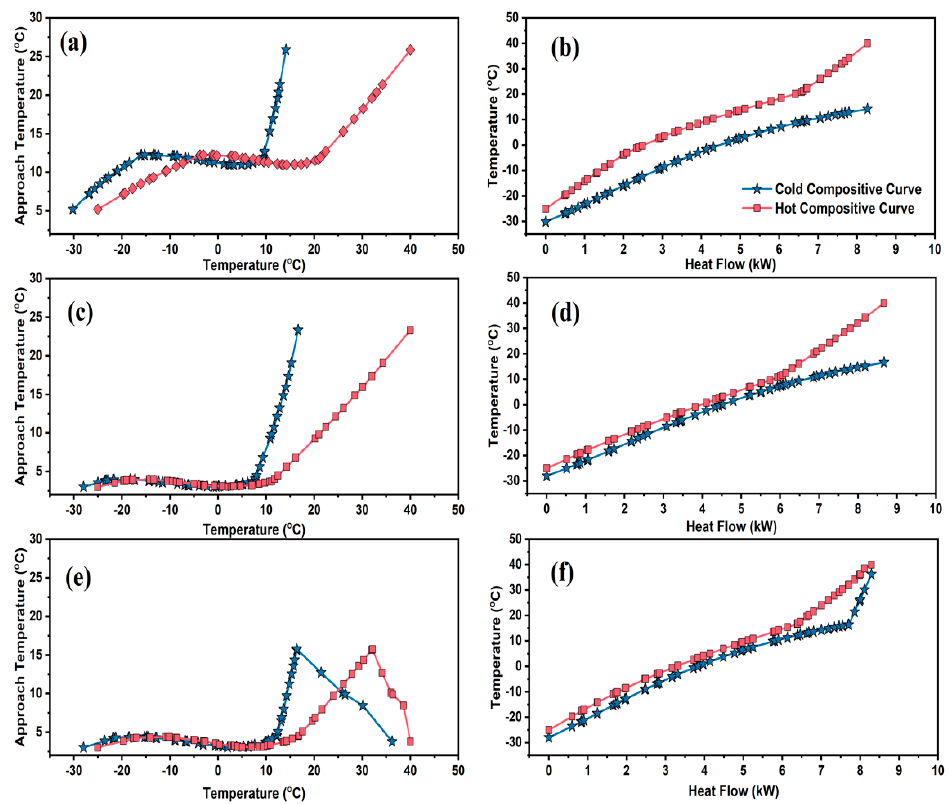
Figure 4. TDCC and THCC of ( a ) and ( b ) the base case, ( c ) and ( d ) SCE-optimized process corresponding to 300 iterations and ( e ) and ( f ) SCE-optimized process corresponding to 700 iterations, for the pre-cooling heat exchanger of MFC–LNG process.